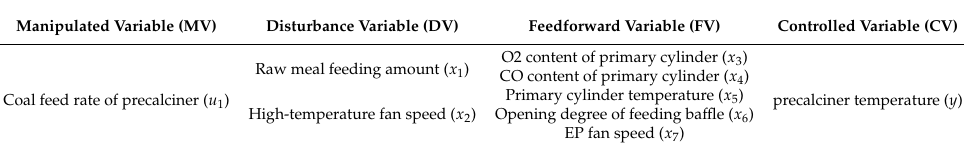
Figure 2. Precalciner structure. Table 1. Variables of the temperature controller.